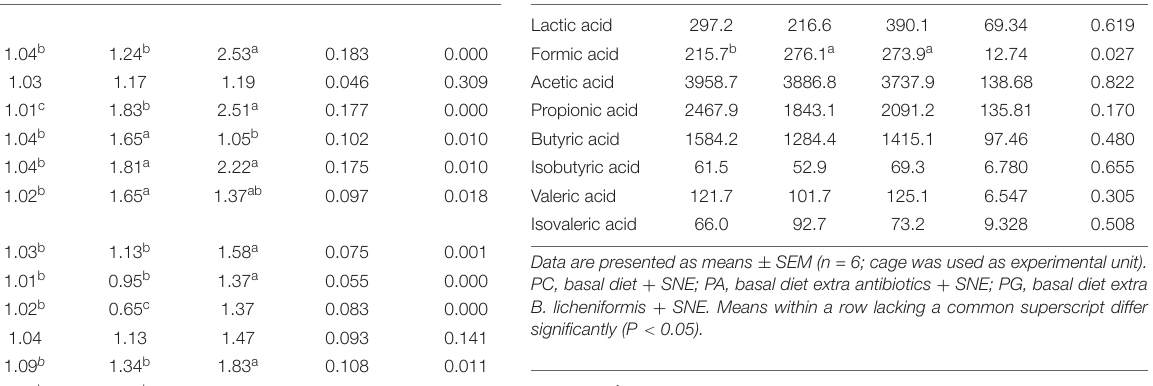
TABLE 8 | Effects of B. licheniformis and enramycin on recovery protein gene expression in jejunum of broilers challenged with SNE. Items